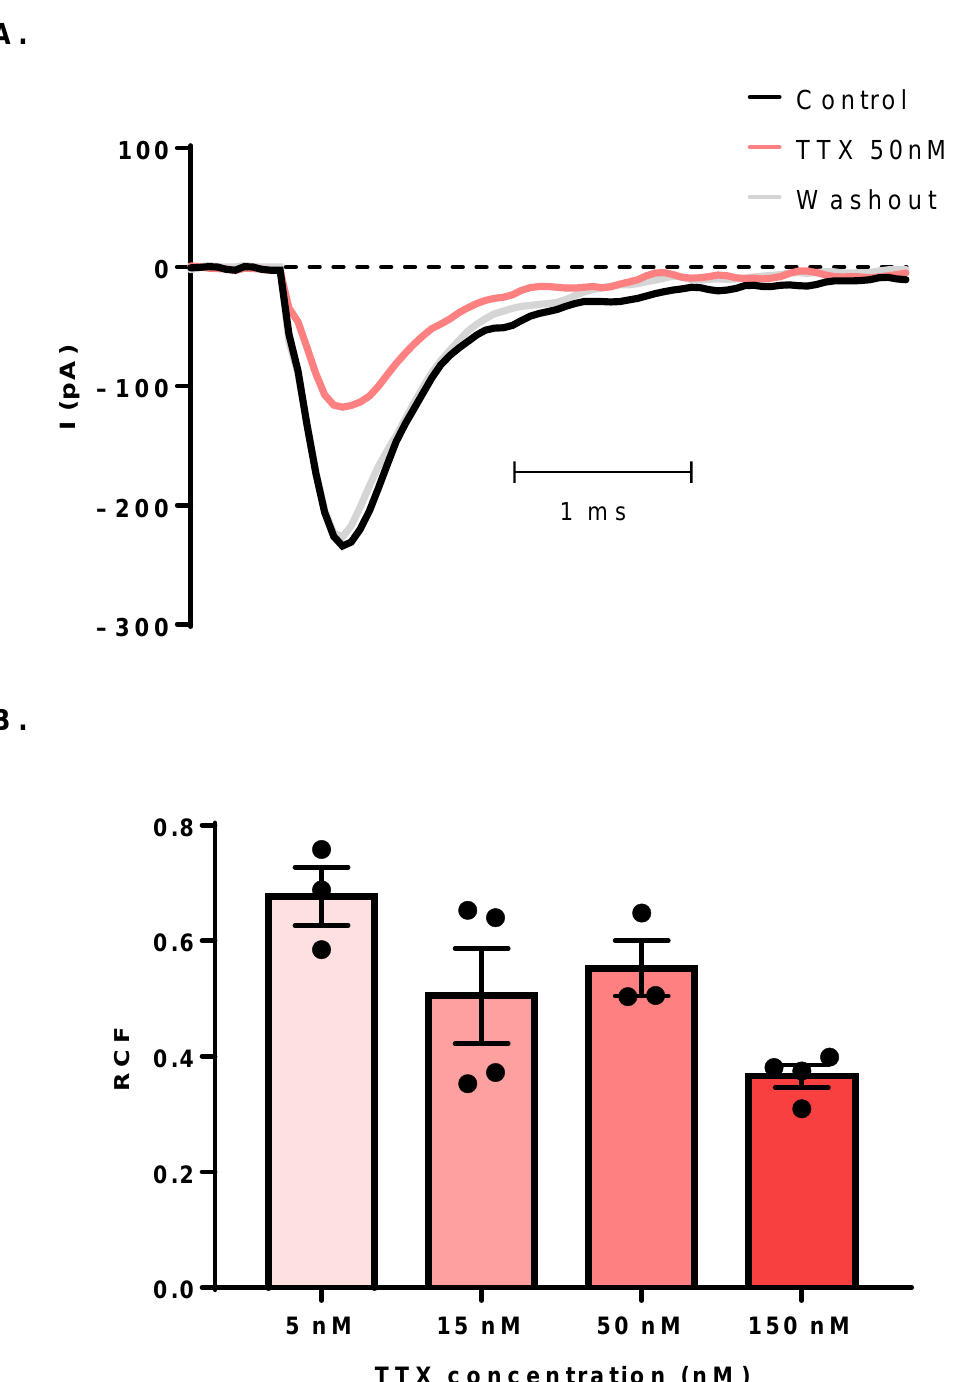
Figure 3. The sodium current is TTX-sensitive. ( A ) The effect of 50 nM TTX on the Na V current. The control trace (black) was recorded in normal extracellular solution, and TTX (red, equilibrium block) caused an inhibition of the inward current, which was reversed by returning to the control solution (gray, washout). All traces were recorded at 0 mV. ( B ) The concentration-dependence of the remaining current fractions (RCF) was at 0 mV. Black symbols indicate the RCFs of individual cells, which were calculated by the equation RCF = I TTX /I control , where I TTX is the current amplitude measured with TTX perfusion, and I control is the current amplitude measured in control solution. Bar heights indicate mean ± SEM.